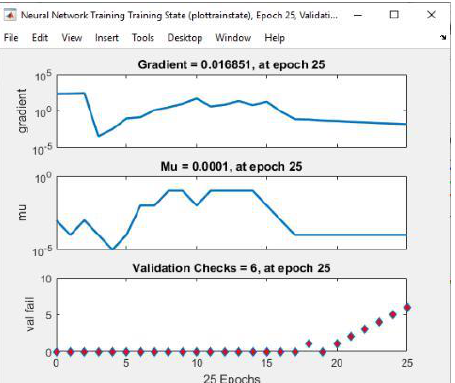
Figure 13 . shows variation in gradient coefficient with respect to number of epochs. The final value of gradient coefficient at epoch number 25 is 0.01 which is approximate near to zero. Minimum the value of gradient coefficient better will be training and testing of networks. From figure it can be seen that gradient value goes on decreasing with increase in number of epochs.